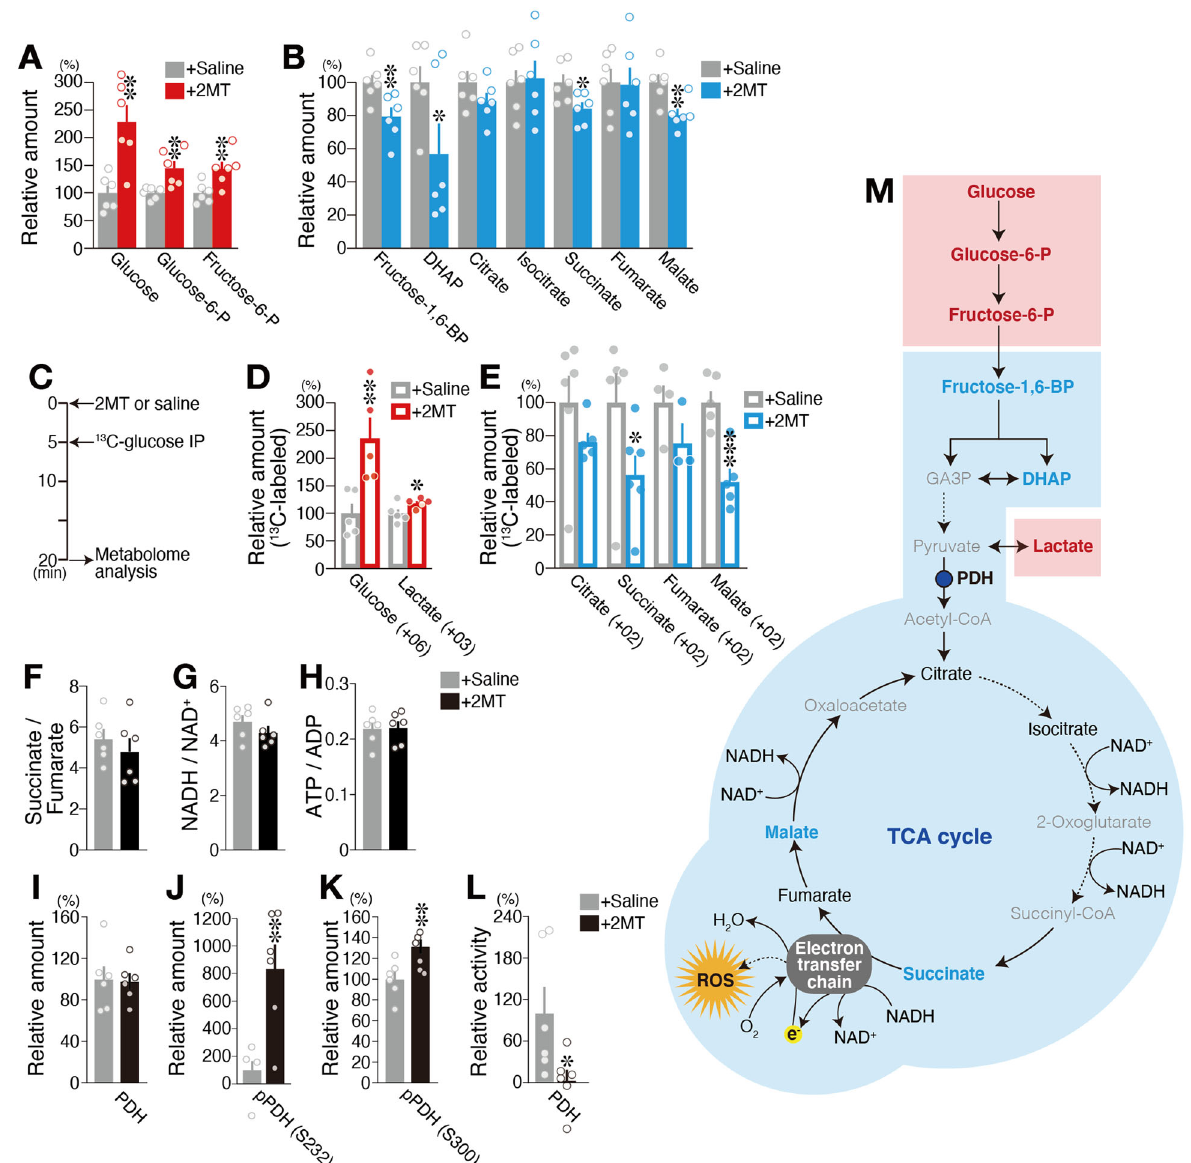
Fig. 3 Innate fear stimuli induce crisis-response metabolism. A – H Metabolome analysis for 2MT-treated and control mice ( n = 6 each). Mean percentages of 13 C-unlabeled ( A , B ) and 13 C-labeled ( D , E ) metabolites in the brain in response to saline (gray) and 2MT (red or blue). Metabolite levels in response to saline presentation were set at 100%. The experimental procedure ( C ) and the ratios of indicated metabolite pairs are also shown ( F – H ). I – L Mean percentages of pyruvate dehydrogenase (PDH) ( I ), pPDH(S232) ( J ), pPDH(S300) ( K ), and PDH activity ( L ) in the brain in response to saline (gray) and 2MT (black). Levels for the saline condition were set at 100% ( n = 6 each). M Schematic diagram of glycolysis and the tricarboxylic acid (TCA) cycle. Red, blue, black, and gray colored are signi fi cantly increased, signi fi cantly decreased, unchanged, and undetected metabolites, respectively. Data are means±SEM. Student ’ s t test was performed between saline and 2MT conditions. * P < 0.05; ** p < 0.01; *** p <